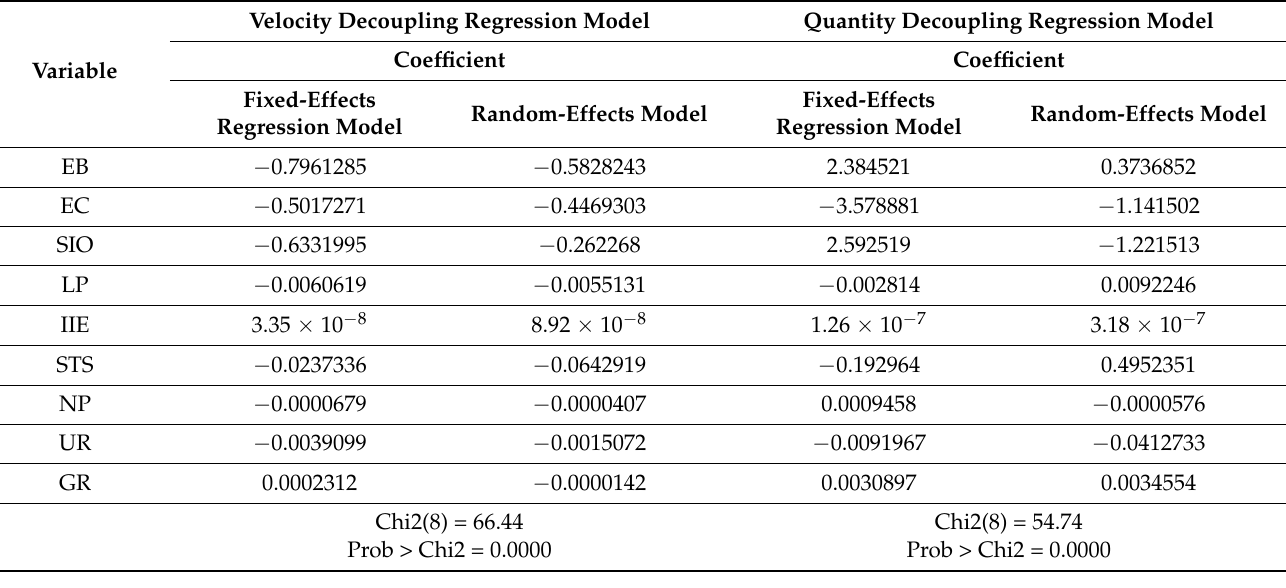
Table 5. Hausman test.